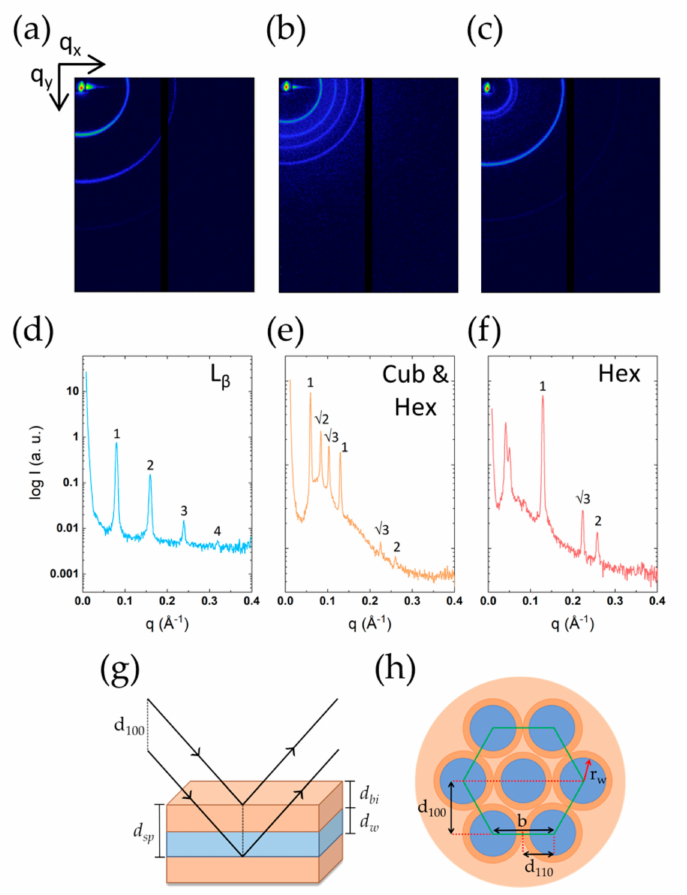
Figure 13. The various geometries exhibited by DODAC in the presence of different alcohols. Top panel ( a – c ): 2D images, middle panel ( d – f ): integrated 1D scattering patterns, and bottom panel ( g , h ): schematic representation of a lamellar and a hexagonal structure and the information obtained from their scattering pattern. ( a , d ) 35 wt% DODAC-15 wt% dodecanol at 25 ◦ C—L β phase; ( b , e ) 35 wt% DODAC-12.5 wt% octanol at 50 ◦ C—Cub and (reversed) Hex phases; ( c , f ) 35 wt%